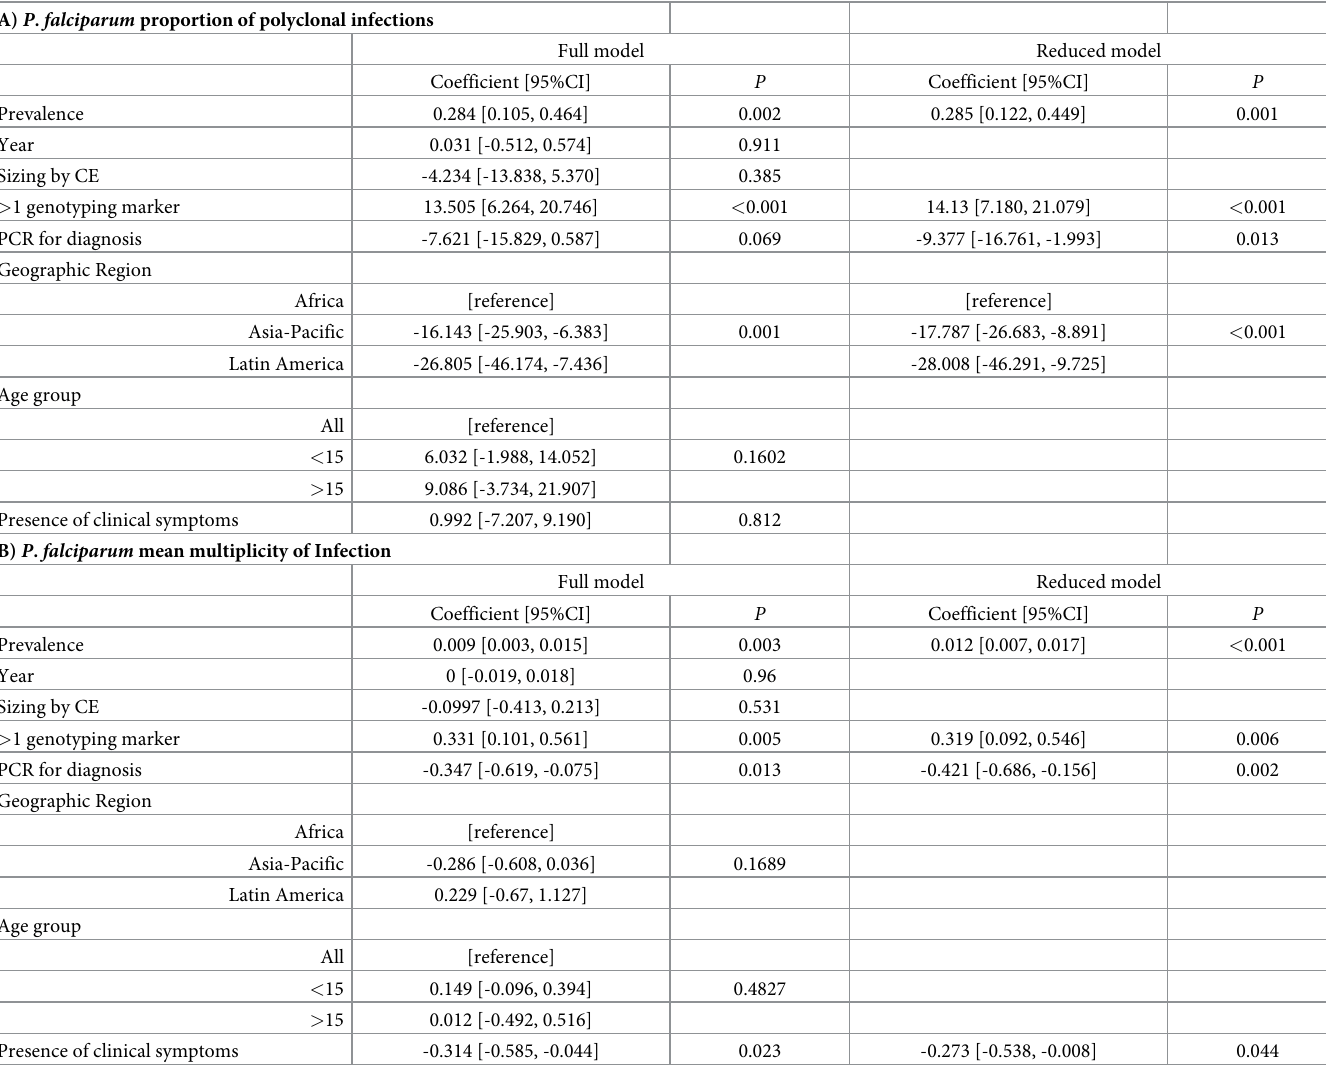
Table 2. Multivariable predictors of A) P . falciparum proportion of polyclonal infections, and B) mean multiple clone infections. 95%CI = 95% confidence interval. A) P . falciparum proportion of polyclonal